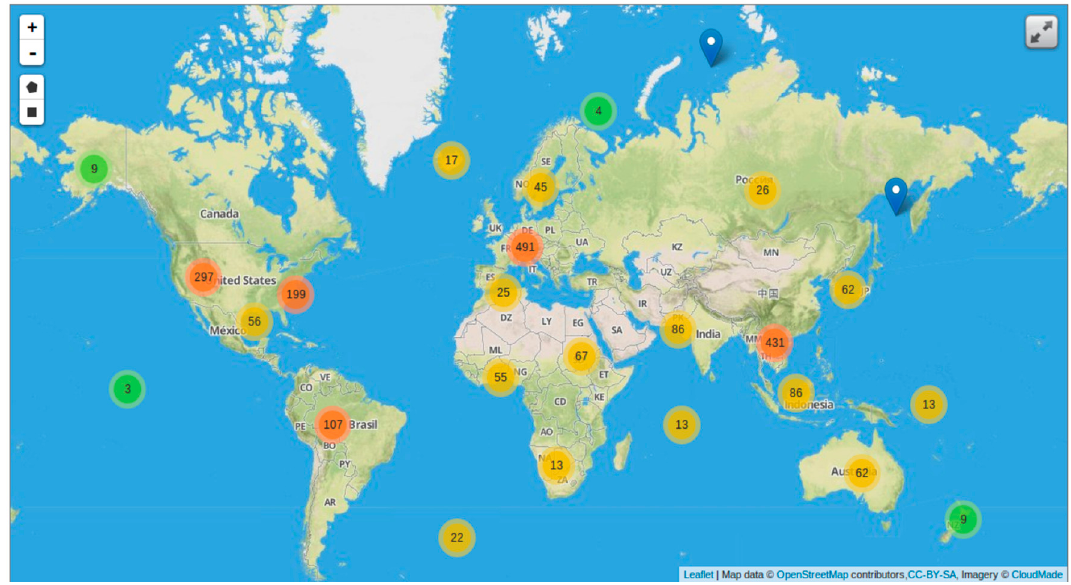
Figure 4. Geo-web user interface. By default, displays all extracted and processed data within the past week. As there is often many thousands of documents spread geographically, documents are clustered at lower zoom levels, with clusters breaking up and becoming more location specific as the user zooms in.